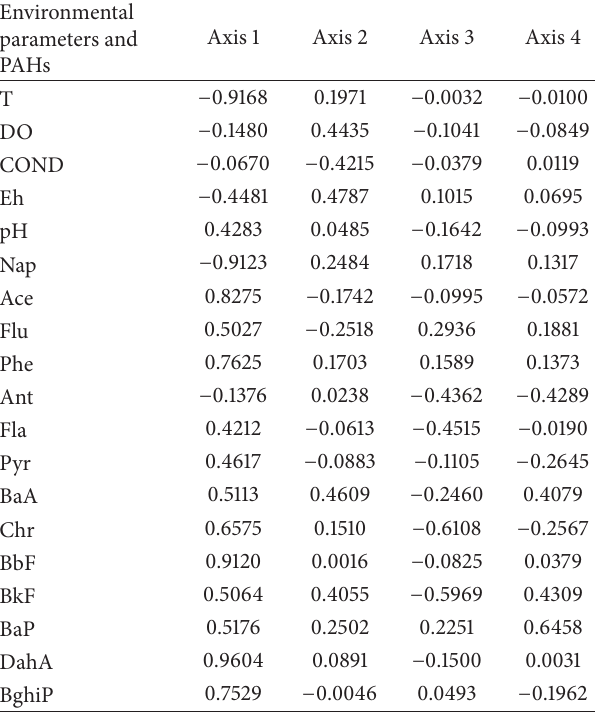
Table 4: Correlation coefficients among environmental indexes, PAHs and RDA ordination axes.